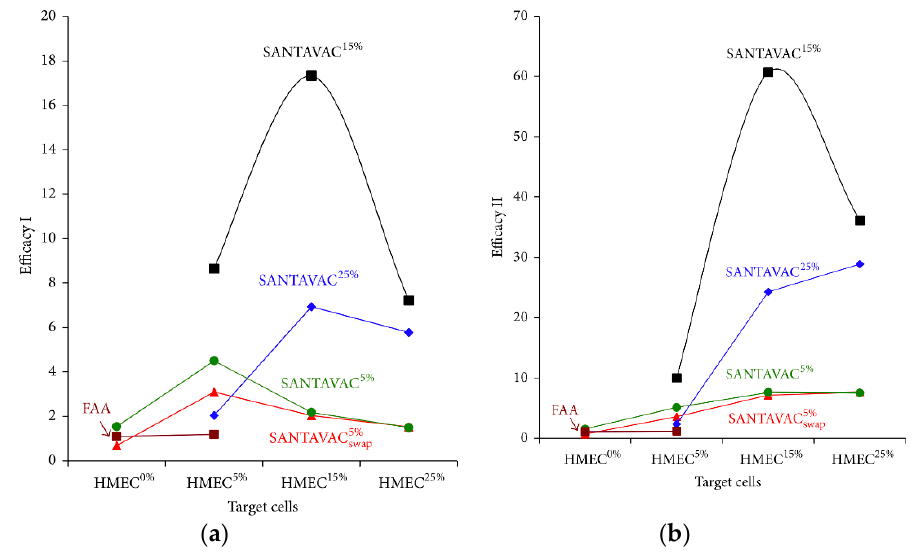
Figure 7. Efficacy of target cell killing by SANTAVAC in cytotoxicity assays (CTA). ( a ) Data are expressed as efficacy I of target cell killing by SANTAVAC. ( b ) Data are expressed as efficacy II of target cell killing by SANTAVAC. Target HMECs were incubated in the presence of effector CTLs at a 1:20 ratio. After three days, CTLs were removed, and target cell viability was determined. Efficacy I was calculated as a ratio of the number of non-stimulated cells in control (i.e., HMEC 0% ) to the number of tumor-stimulated cells in the experiment. Efficacy II was calculated as a ratio of the number of tumor-stimulated cells in control (i.e., HMEC 5% , HMEC 15% , or HMEC 25% ) to the number of tumor-stimulated cells in the experiment, that is, the percentage of the tumor-conditioned medium in control was the same as in the experiment. Efficacy I allows in vitro estimation of the SANTAVAC efficacy by demonstrating how many endothelial cells in the tumor vasculature will be destroyed before one endothelial cell in normal tissue is destroyed (used to predict vaccine safety). Efficacy II allows in vitro estimation of the SANTAVAC efficacy by demonstrating the degree of HMEC proliferation suppression in the tumor vasculature and is used to establish the degree by which the vaccine can arrest tumor growth (predicted vaccine therapeutic effect). For efficacy calculation, the data representing the mean value of three independent measurements was used. “FAA” indicates the data related to the control ( ■ ) in CTA where fibroblast-associated antigens were used to simulate CTL. “swap” ( ▲ ) indicates CTA data where primary cell cultures used to generate SANTAVAC and primary cell cultures which were used as target cells were swapped (it was done to demonstrate the reproducibility of the CTA results at defined percentages of the tumor-conditioned medium used to stimulate HMEC). Percentage values indicated in the superscript and label shape correspond to the percentage ( ● – 5%, ■ – 15%, ♦ – 25%) of the tumor-conditioned medium used to stimulate target HMEC or HMEC used to generate SANTAVAC for targeting immune response in CTA. Adapted from [92].